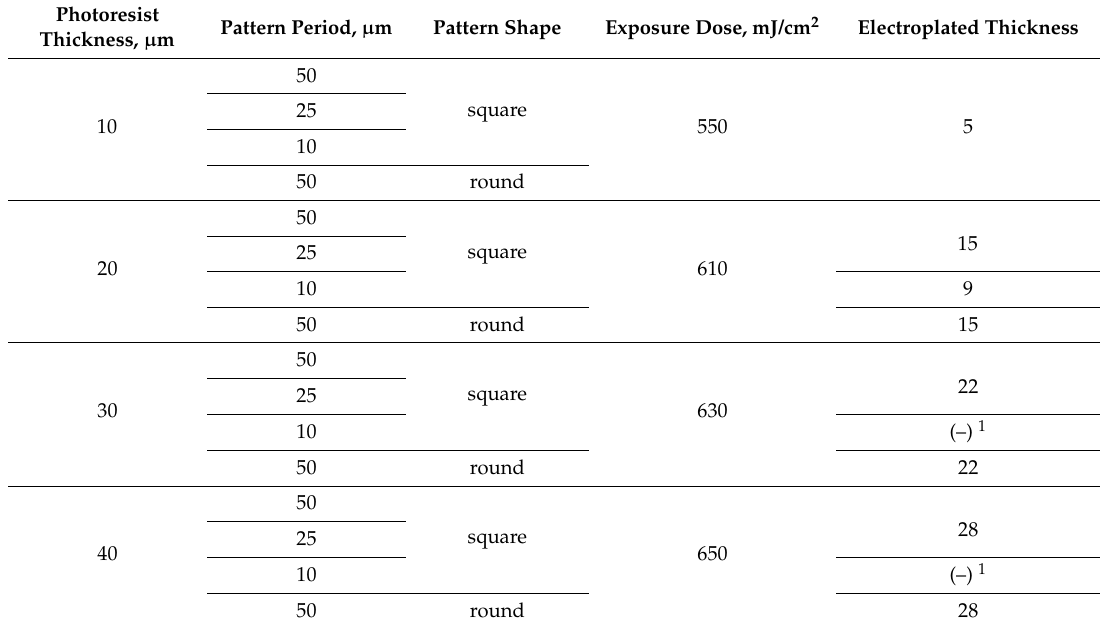
Table 1. Main characteristics of the fabricated